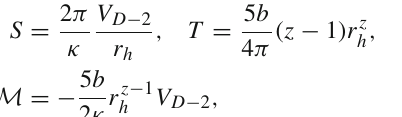
perature above which the configurations with z > 1 have a lower energy state and thus are preferable with respect to the thermodynamics. Right at the critical temperature, both configurations with z = 1 and z > 1 would have the